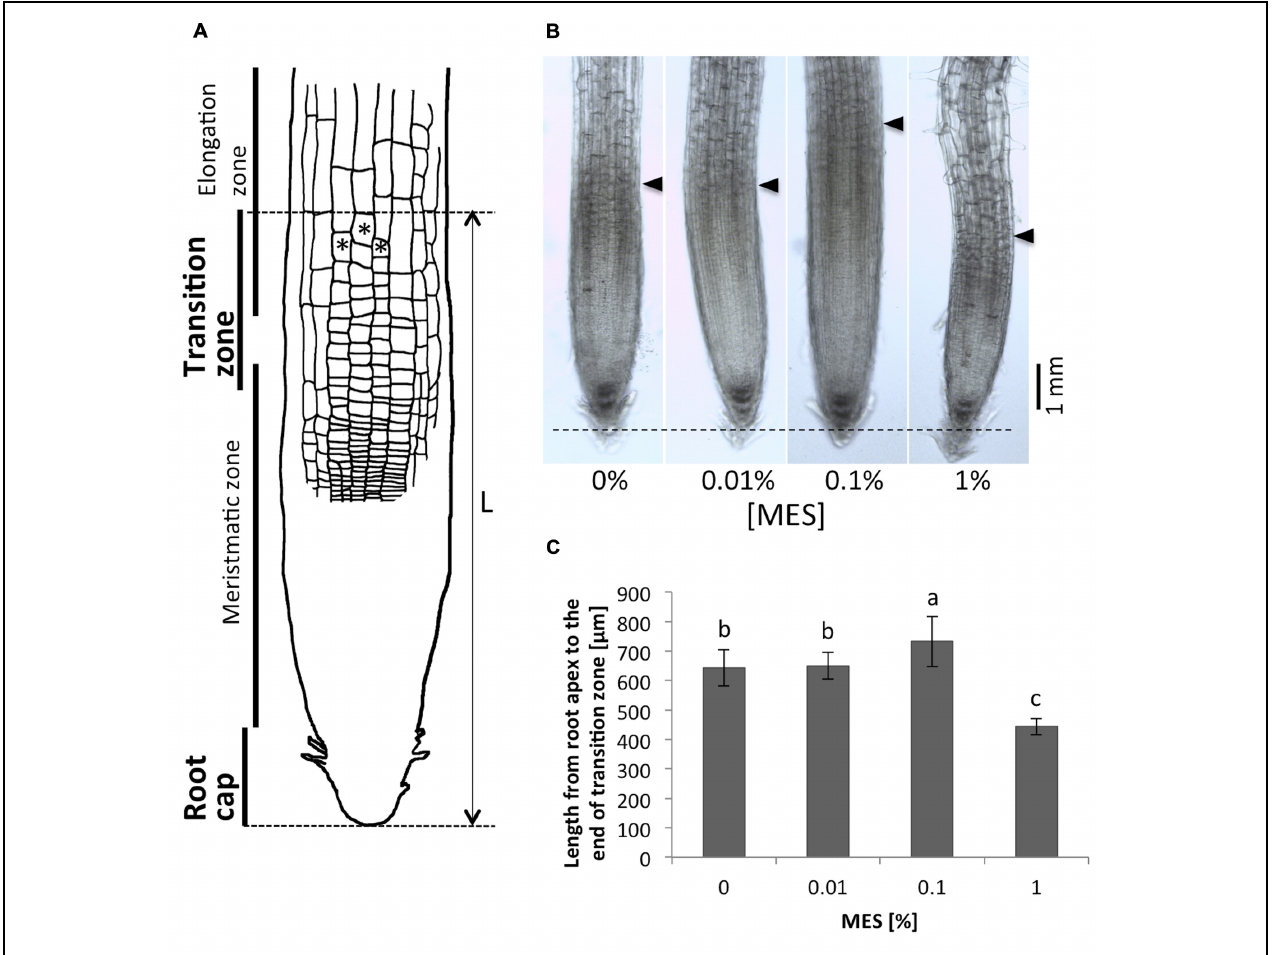
FIGURE 2 | Comparison of the root apex lengths. (A) A scheme of the root apex. Cells with asterisks indicate the typical cells in transition zone. In this study, we define the border between transition zone and elongation zone as following morphological category: the cell lengths obtain values which are two times higher as the cell widths (Baluška et al., 2010). (B) Microscope images of the root apices. Tips of black triangulates indicate positions of the end of transition zone. A dashed horizontal line indicates the position of root apices. (C) Lengths of the root apices (from the root tip to the end of the transition zone). Error bars indicate standard deviations of the mean ( n = 9–11). Different letters indicate significant difference (Tukey’s HSD test, P <